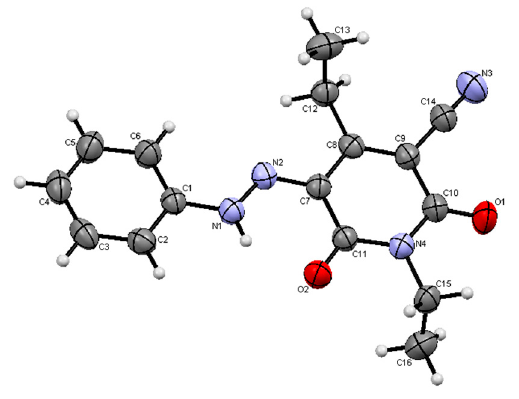
Figure 2. ORTEP of dye 18a.